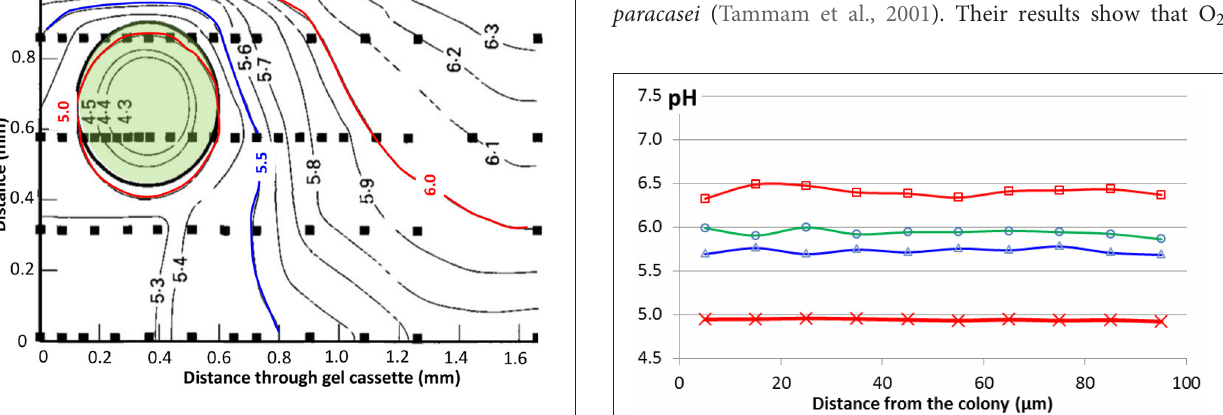
FIGURE 7 | pH profiles measured using a pH-sensitive fluorophore (C-Snarf-4) and confocal microscopy for a colony (radius = 65 µ m) growing in a model cheese throughout acidification: 19h ( ), 24h ( ), 26h ( △ ), and all measurements from 42 to 72h (red bold line, X). Adapted from Jeanson et al.